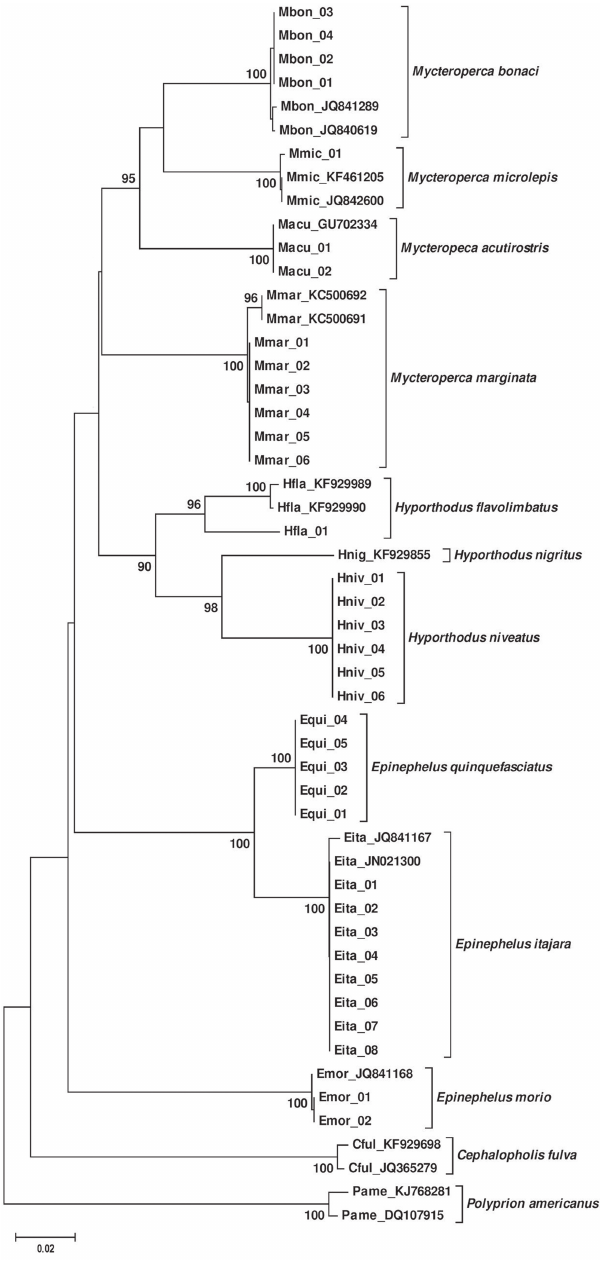
Fig. 1. Phylogram based on the amplification of the sequence of the Cytochrome Oxidase I gene of the commercially- exploited species of fishes of the families Epinephelidae and Polyprion americanus (Polyprionidae). The samples collected in the present study are underlined and those obtained from the GenBank database appear together with their accession